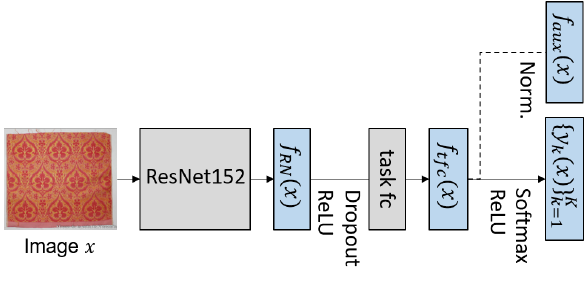
Figure 1. CNN architecture. An input image x is presented to a ResNet152 (He et al., 2016), resulting in a feature vector f RN ( x ) , which is then mapped to a task-specific representation f tfc ( x ) by a sub-network task fc . f tfc ( x ) is presented both to a classification head and to a clustering head. The classification head takes f tfc ( x ) as input for a ReLU activation and maps the output to normalized class scores y k ( x ) of every class k using a softmax layer. The clustering head consists of a normalization of f tfc ( x ) to unit length, resulting in a feature vector f aux ( x ) . The broken line indicates that the clustering head is only active in